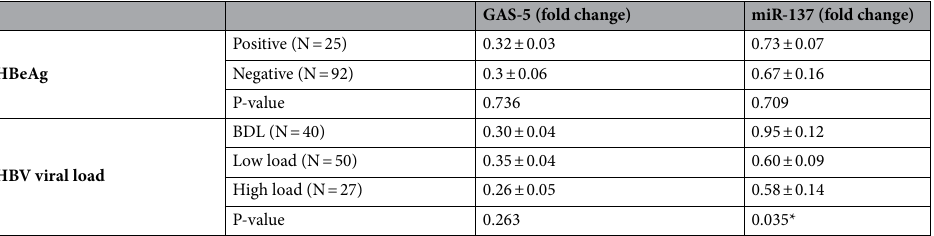
Table 6. Relation between HBeAg and HBV viral load and lncRNA growth arrest-specific 5 (GAS5) and miR- 137 serum expression levels among chronic HBV cases. BDL below detection level (below 20 copies/ml), low